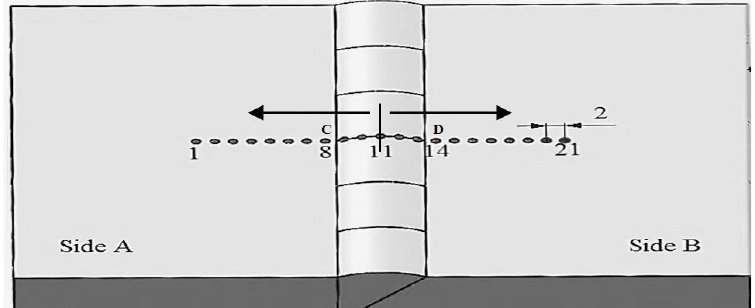
Figure 3. Representation of XRD measurement points in sample